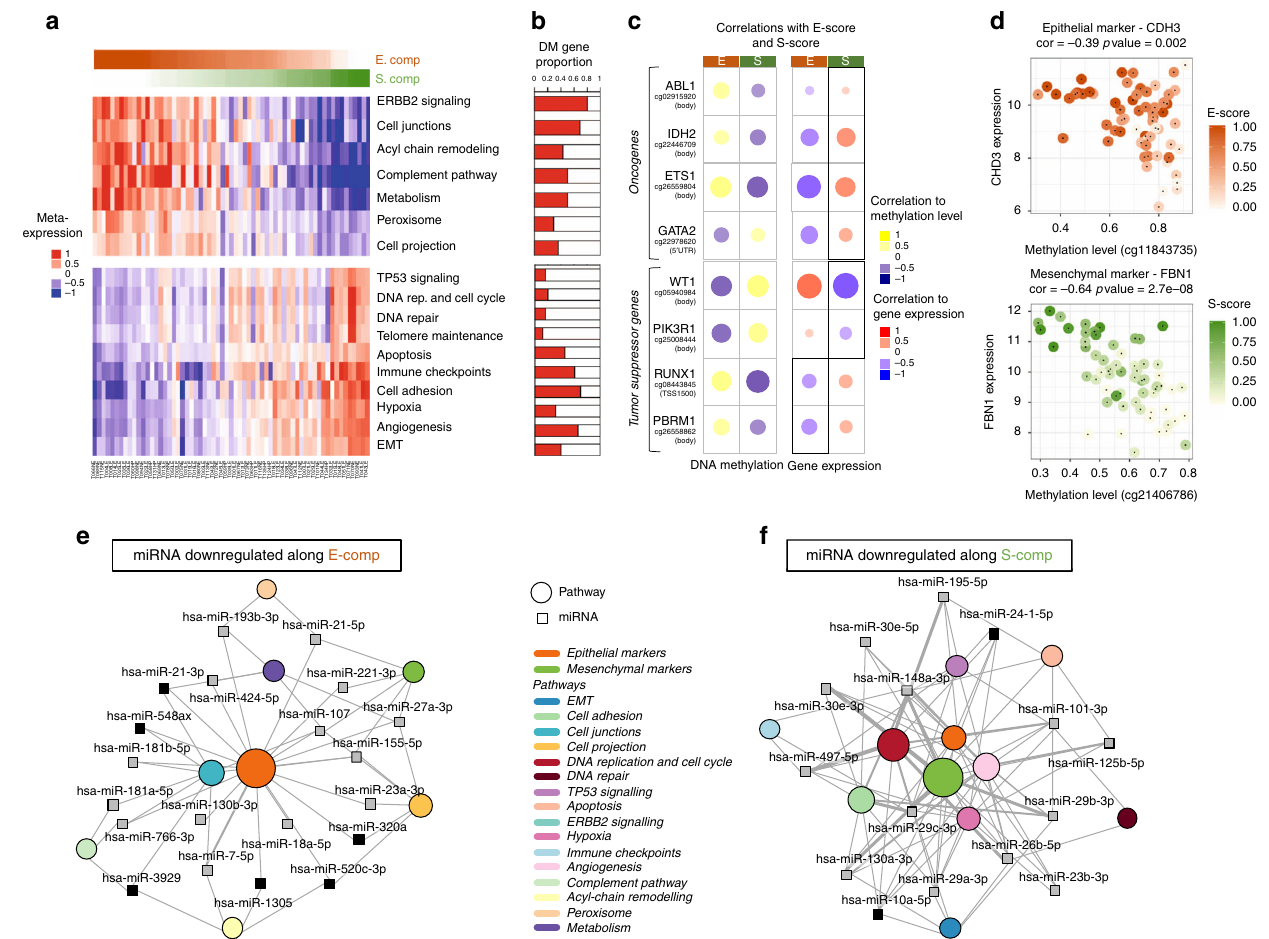
Fig. 2 Component-speci fi c pathways and epigenetic regulation. a Expression heatmap of the component-speci fi c pathways ( P value < 0.05, Fisher ’ s exact test). For each pathway, the mean expression pro fi le of the associated deregulated genes was calculated. Samples were ordered by the ratio of rescaled E - score and S -score. b Lateral bars correspond to each pathway and to the proportion of genes whose expression levels were correlated with the DNA methylation level (DM, differentially methylated). c Heatmap of the correlations between DNA methylation and gene expression with the E -score and S - score for known oncogenes and tumor suppressor genes (FDR adjusted P value < 0.05, Pearson ’ s correlation test). The circle size is proportional to the correlation coef fi cient value. d Correlation plots between the DNA methylation level and the CDH3 (epithelial marker) and FBN1 (mesenchymal marker) gene expression levels; color gradient changes correspond to the E -score or S -score. For each plot, the correlation coef fi cient and P value are shown (Pearson ’ s correlation test). e , f The network displays miRNAs whose expression levels are negatively correlated with the E -score ( e ) or S -score ( f ) and their targeted pathways (among the component-speci fi c pathways between E-comp and S-comp) based on validated miRNA-target associations. The network was restricted to miRNAs that were negatively correlated with the expression of their target (FDR adjusted P value < 0.05, Pearson ’ s correlation test) and targeted at least 2 ( e ) out of 5 ( f ) different component-speci fi c pathways. The edge thickness is proportional to the number of genes in the pathway targeted by the miRNA. The circle size of each pathway is proportional to the number of genes targeted by the miRNA in the network. miRNAs that have been described in the MPM literature are represented by a gray square, and undescribed miRNAs are represented by a black